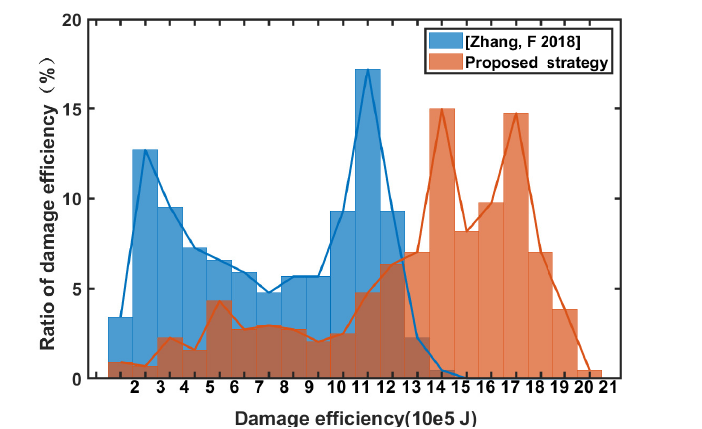
Figure 13. Damage efficiency of [13].